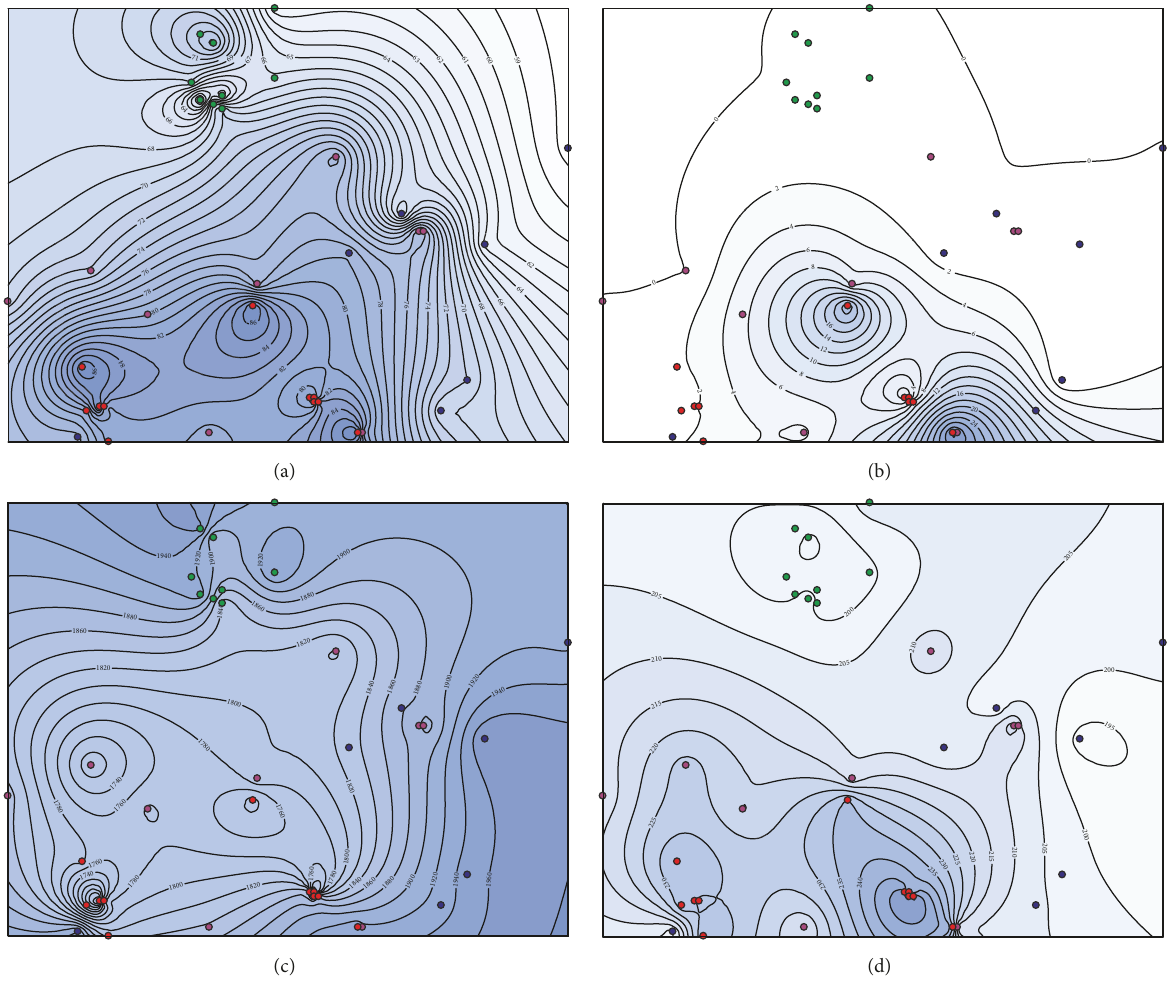
Figure 9: Contour maps of the geothermal spring samples in the research area. Figures 9(a), 9(b), and 9(c) are the contour maps of measured emerging temperatures, mass flow rates, and TDS of the spring samples, respectively; Figure 9(d) is the contour map of reasonable temperatures of geothermal reservoirs determined in “Selected Reservoir